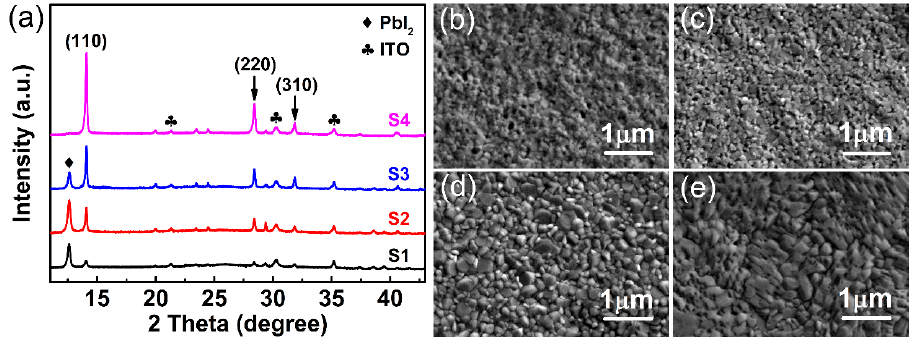
Figure 1. ( a ) XRD patterns of the perovskite films fabricated from precursor solutions with different MAI:PbI 2 ratios. ( b ) SEM images for the surface morphology of S1 (MAI:PbI 2 ratio 0.25:1), ( c ) S2 (MAI:PbI 2 ratio 0.5:1), ( d ) S3 (MAI:PbI 2 ratio 0.75:1), ( e ) S4 (MAI:PbI 2 ratio 1:1). Nanomaterials 2019 , 9 , x FOR PEER REVIEW